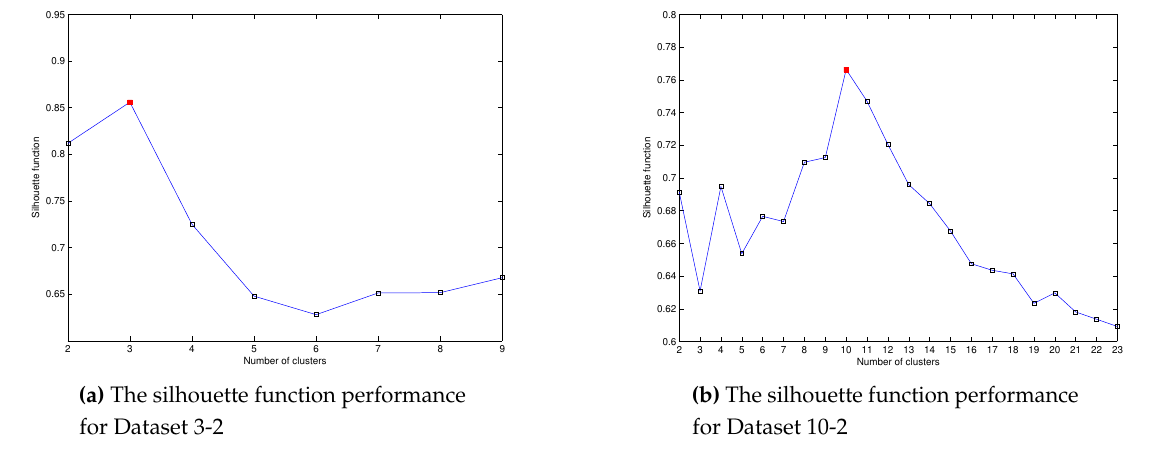
Figure 2. The silhouette function performance to ( a ) Dataset 3-2 and ( b ) Dataset 10-2, when the number of clusters changes from 2 to K max